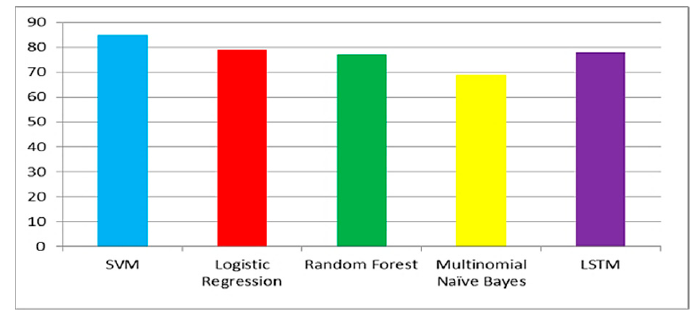
Figure 6. Model accuracy comparison for the COVID-19 vaccine query.